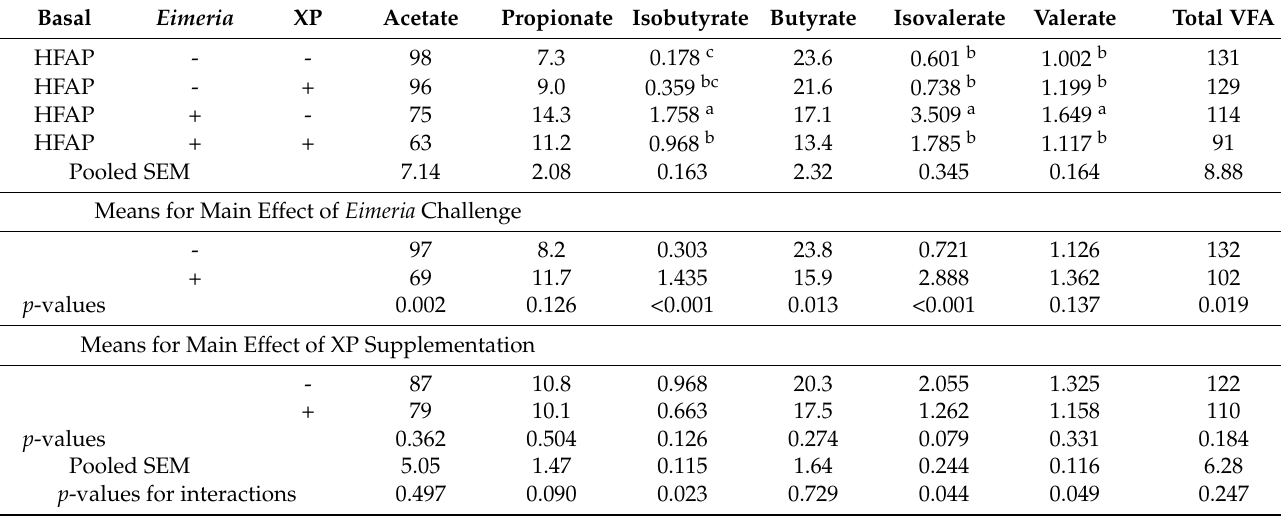
Table 10. Short-chain fatty acid profile (mM) in cecal content for the broiler chickens challenged or unchallenged with mixed Eimeria spp. in response to feeding diets with high fiber and adequate protein levels with or without enzyme supplementation (Expt. 1).